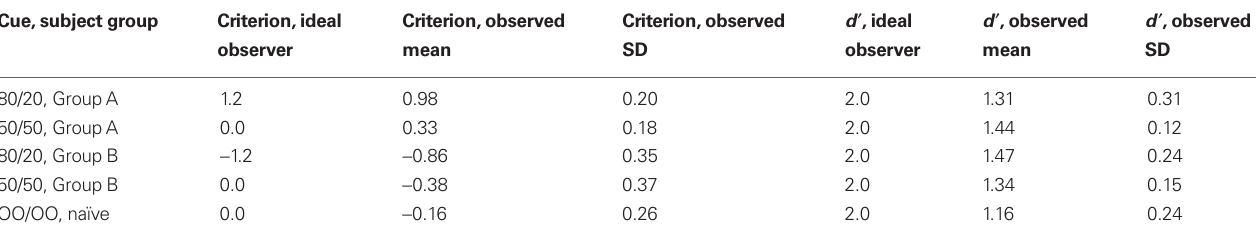
Table 1 | Criterion and d ′